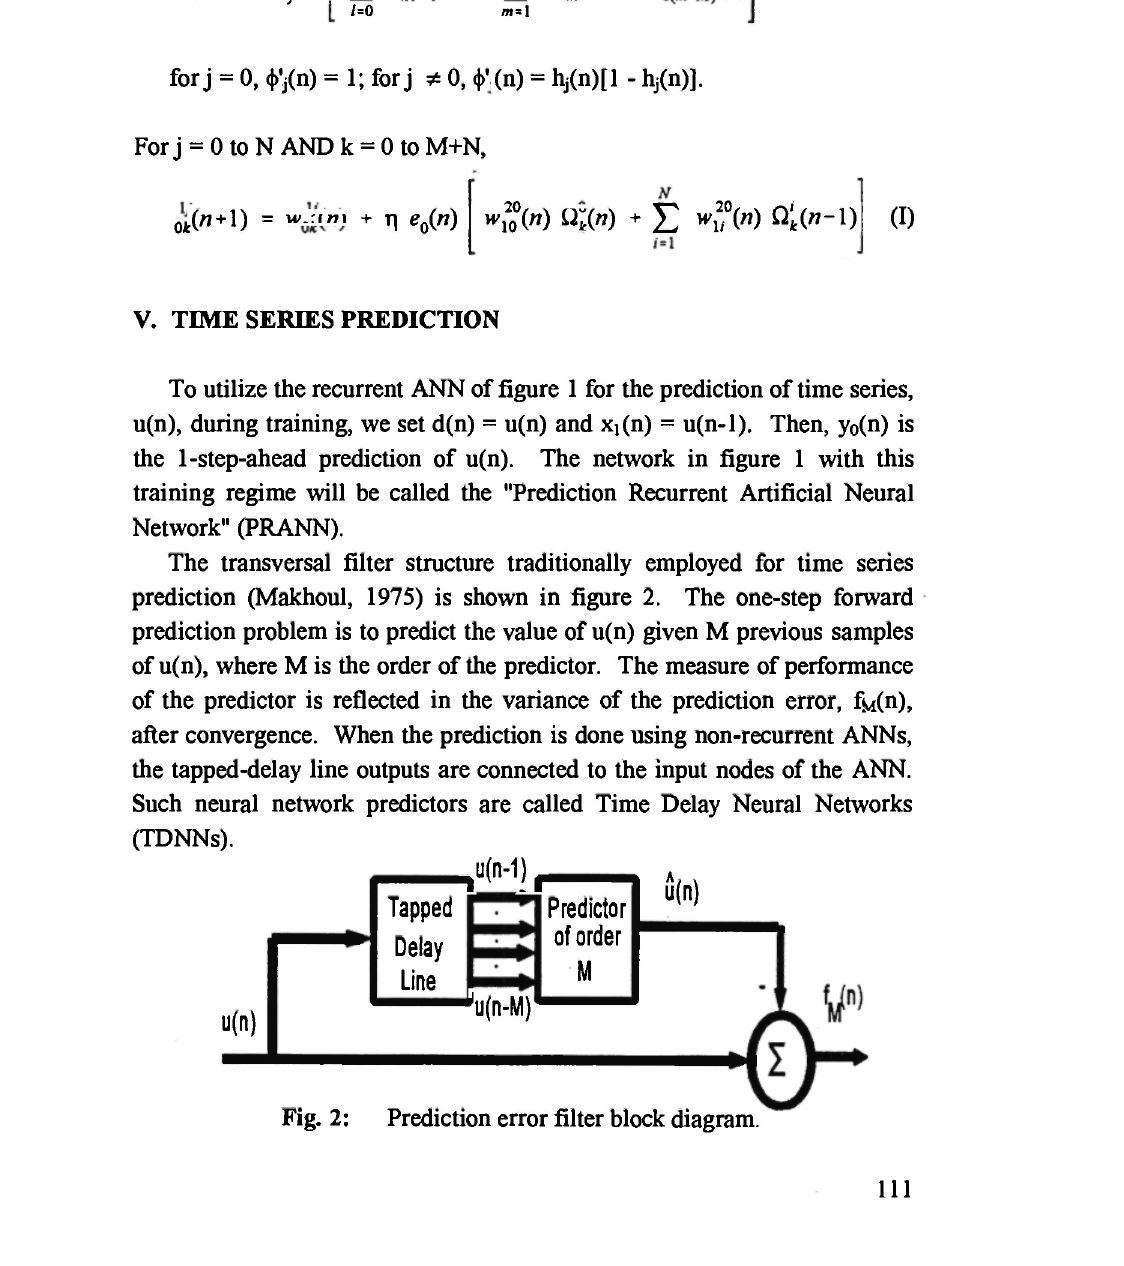
Fig. 2: Prediction error filter block